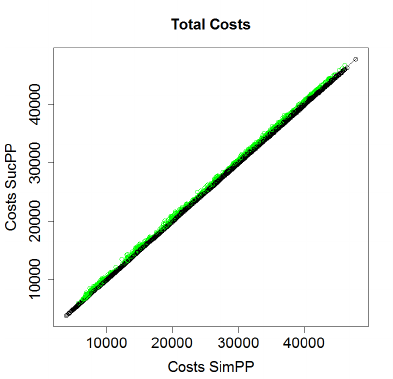
Figure 10. Cost comparison of SucPP and SimPP; the green circles indicate booms with a cost saving of 1% or more by using SimPP.